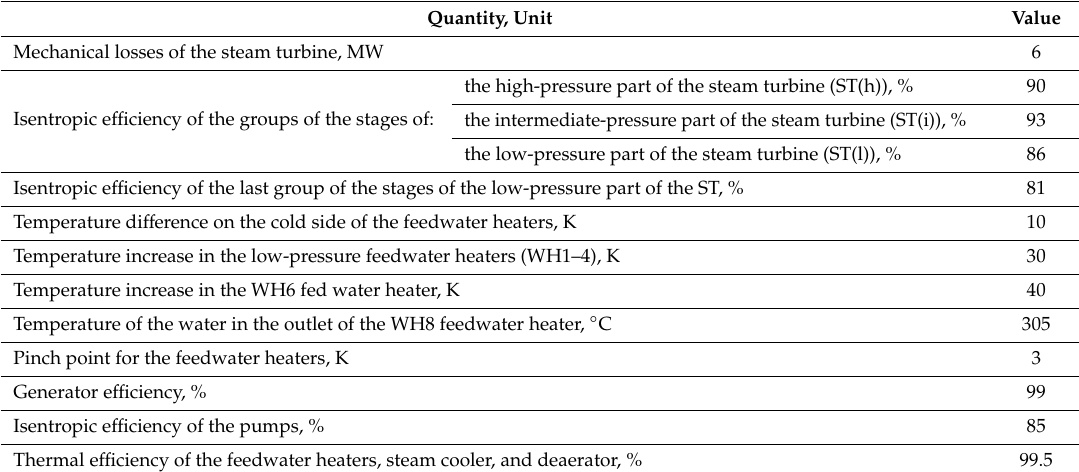
Table 1. Steam turbine unit